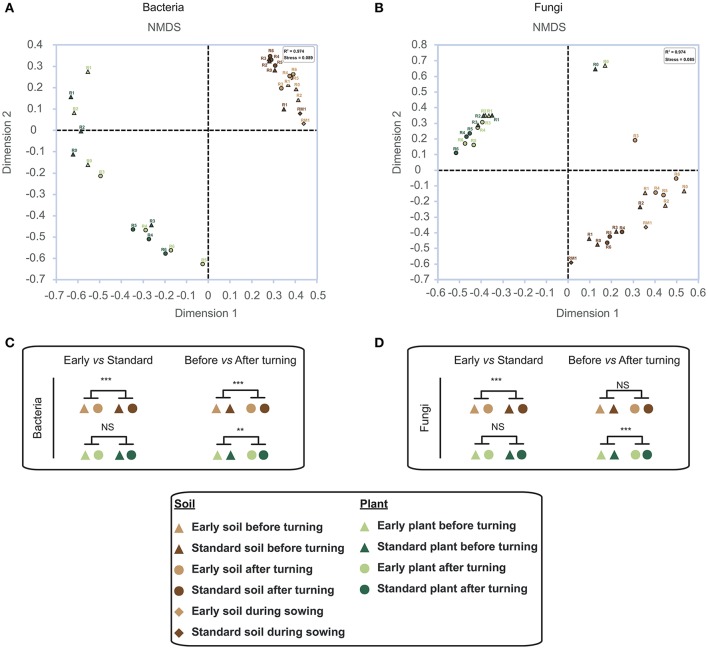
Non-metric multidimensional scaling (NMDS) of bacterial (A) and fungal (B) community structure based on Yue & Clayton distance matrix. Different colors indicate the source samples (light brown, soil early harvest; dark brown, soil standard harvest; light green, plant early harvest; dark green, plant standard harvest). Triangles, samples before swath turning; circles, samples after swath turning; lozenge, soil sample during sowing. (C,D) statistically significant clustering based on AMOVA.